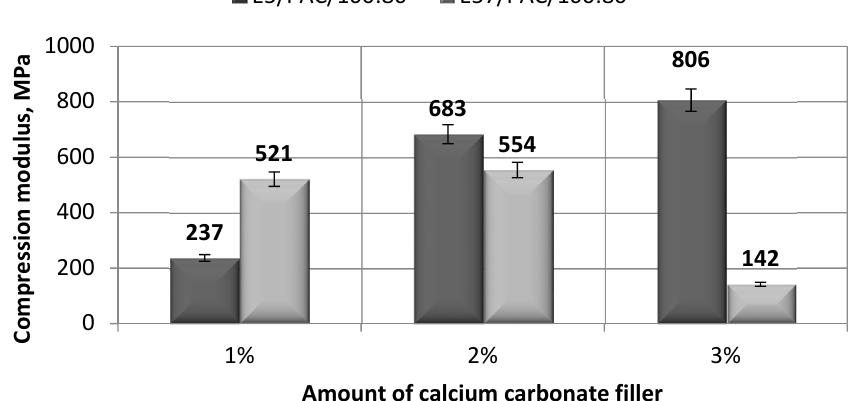
Figure 3. Comparison of the compression modulus between the E5/PAC/100:80 and E57/PAC/100:80 epoxy specimens modified by the calcium carbonate filler.